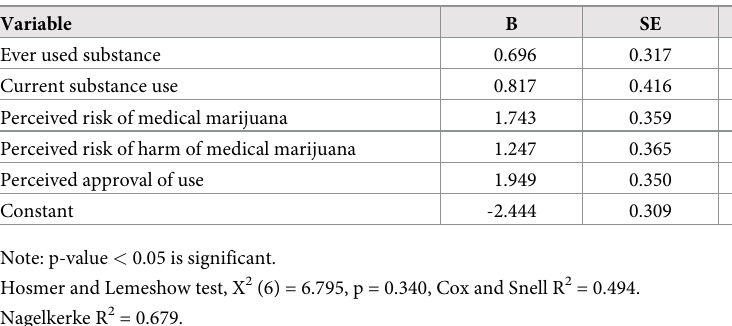
Table 5. Multiple logistic regression analysis predicting acceptance towards decriminalization of medical marijuana in